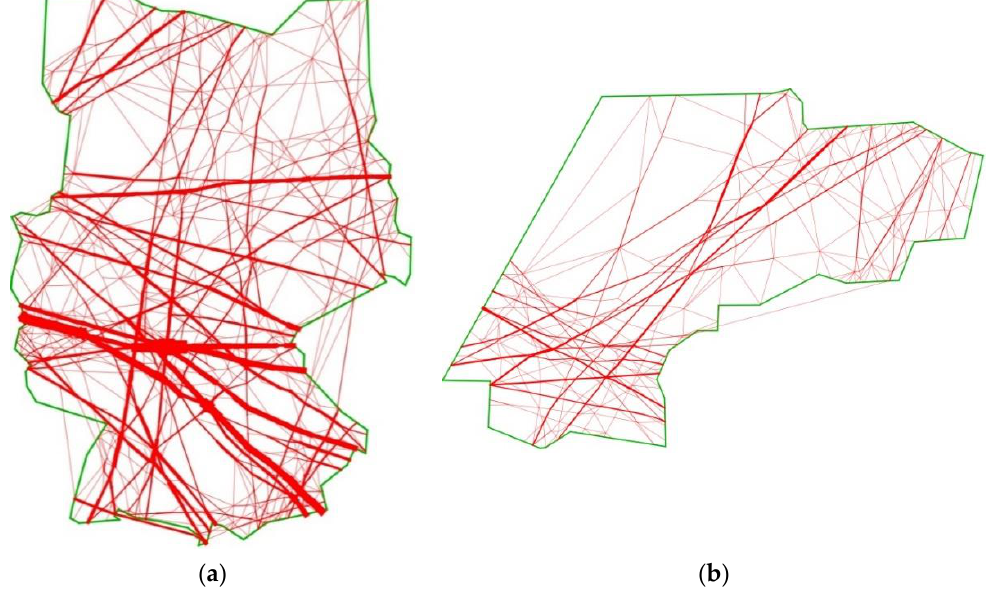
Figure 11. Reduced main-flow system for Scenario 1 ( a ) and Scenario 2 ( b ). Line thickness reflects the number of flights using a link. Table 4. Number of entry and exit clusters.